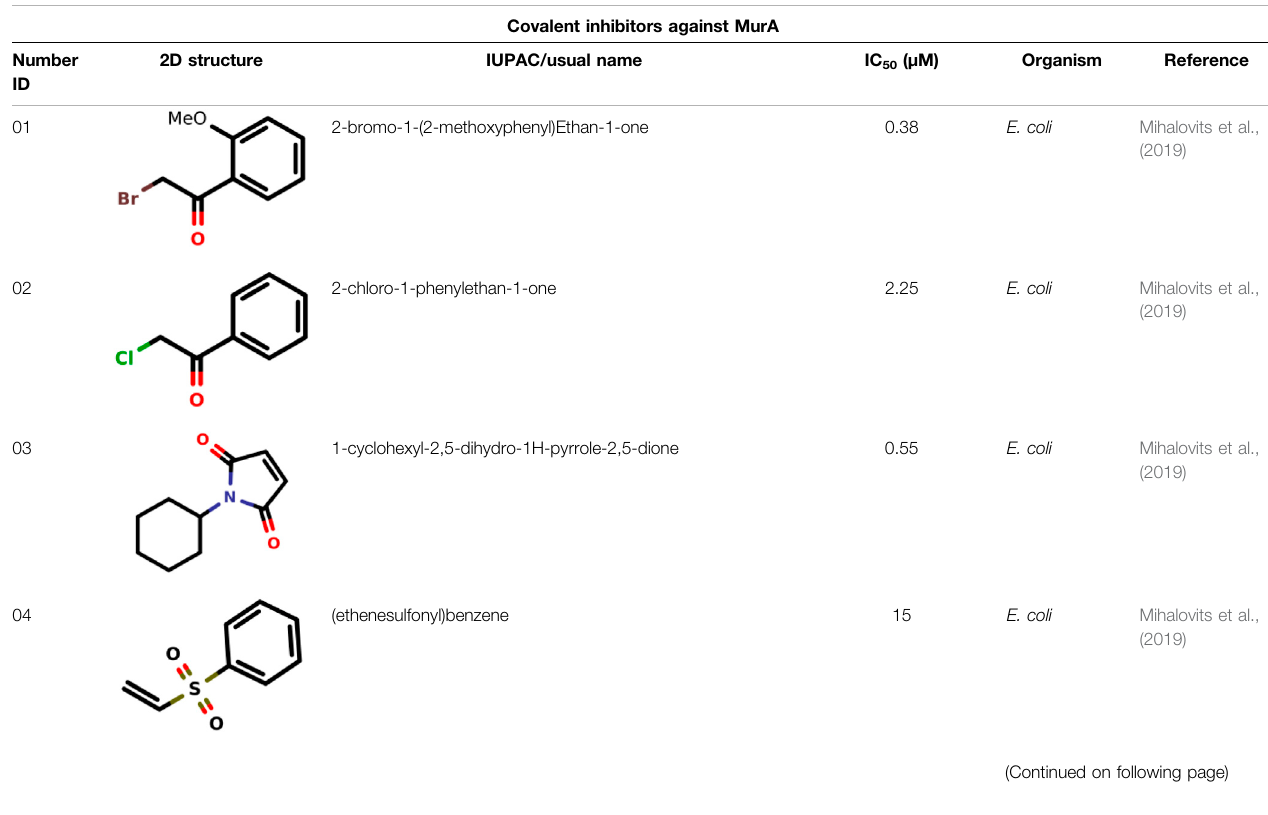
TABLE1| SomeexamplesofcovalentinhibitorsagainstMurAindifferentorganisms,suchas Escherichiacoli(E.coli),Enterobactercloacae(E.cloacae) and Staphylococcus aureus (S. aureus)